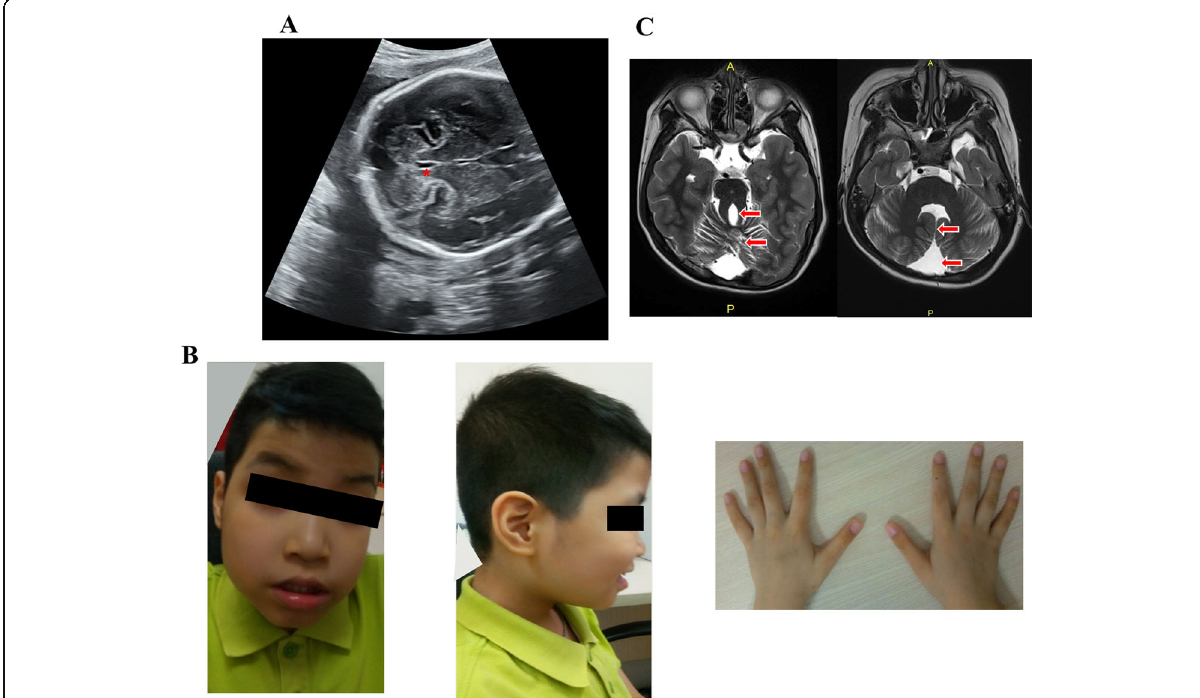
Fig. 1 a Ultrasound at 26 + 6 weeks of gestation showing an abnormal enlarged fourth ventricle (red asterisk) and the ventricle floor is abnormal. b Photographs of the face (left image) and right profile (middle image) showing typical facial features of Joubert syndrome including prominent forehead, high arched eyebrows, bilateral ptosis, hypertelorism, lower lip eversion (left and middle image), mild clinodactyly of the fifth finger and tapered fingers (right image). c Axial MRI through the cerebellum and brain stem showing cerebellar vermis hypoplasia, thick and elongated superior cerebellar peduncles (red arrows, left image) and absence of the cerebellar vermis, deep interpeduncular fossa and the fourth ventricle has a bat-wing configuration (red arrows, right